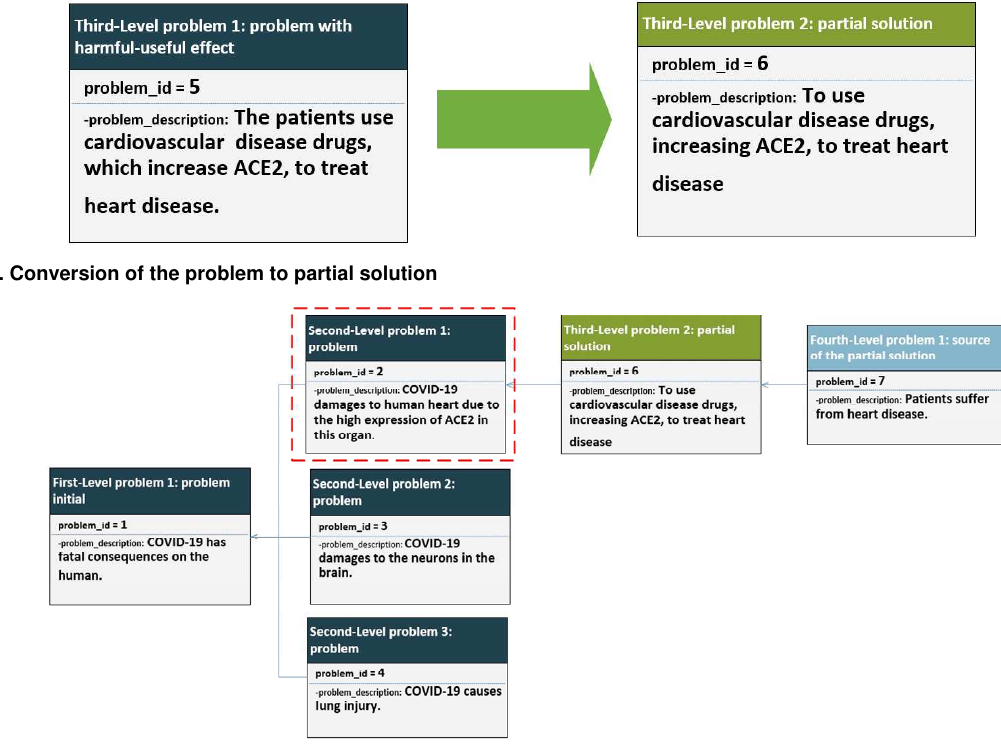
Figure 9. Inverse Problem Graph of the case study in the first